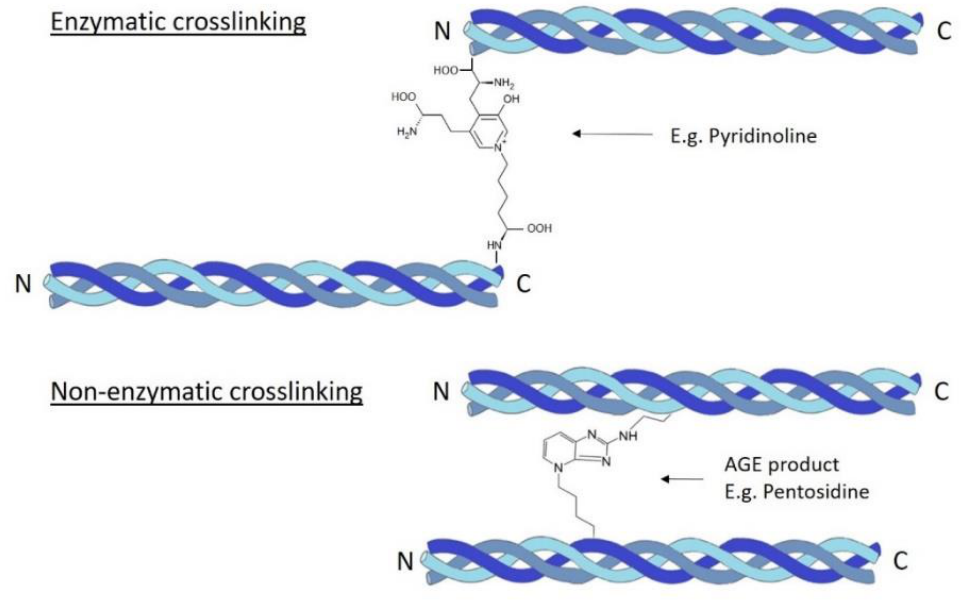
Figure 5. Schematic representation of collagen enzymatic and non-enzymatic crosslinking. Legend: advanced glycation end-product (AGE).